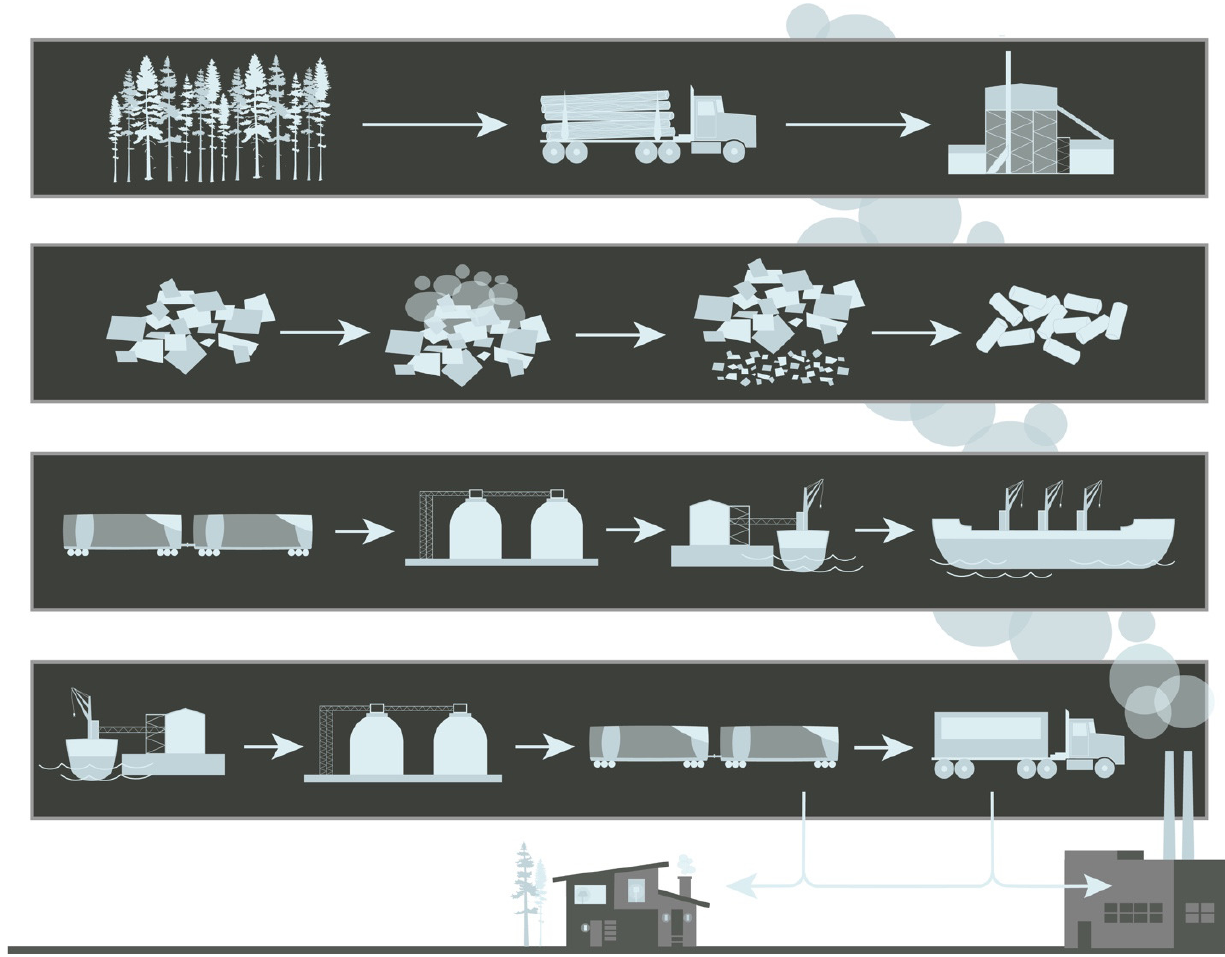
Figure 1. Wood pellet supply chain diagram. Source: Ramos (2020, p. 6). Roberts, November 23, 2020). A company in the